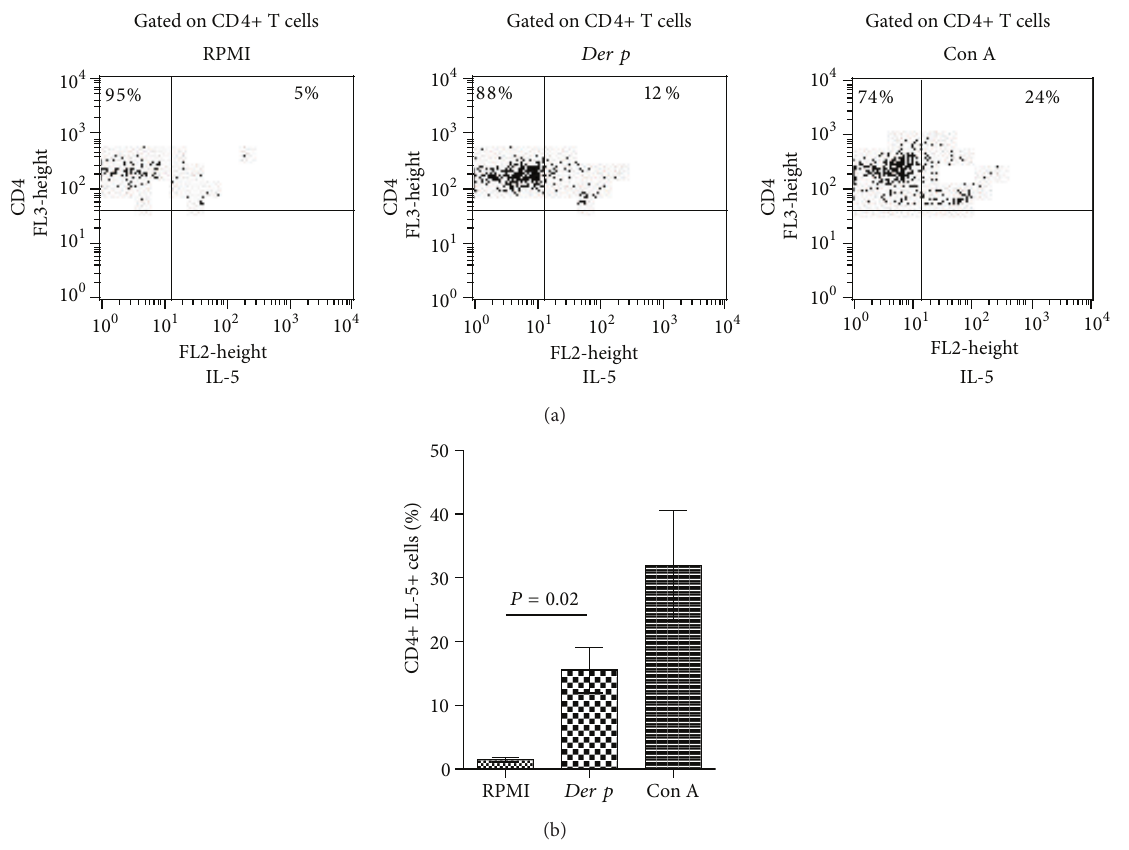
Figure 6: Frequency of CD4+ IL-5+ cells after Der p -stimulation. PBMC were Der p -stimulated for 72h and stained for CD4 and intracellular IL-5 as described in materials and methods. (a) Left panel, nonstimulated cells, central panel, Der p -stimulated cells and right panel, and Con A-stimulated cells; representative dot plots from three PAC patients. (b) Comparison of the frequency of CD4+IL-5+ cells among different stimuli. Data are expressed as mean ±